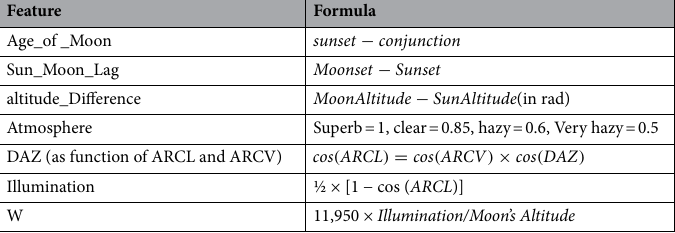
Table 1. Formulas for some features values computation 14,26,27,44 .